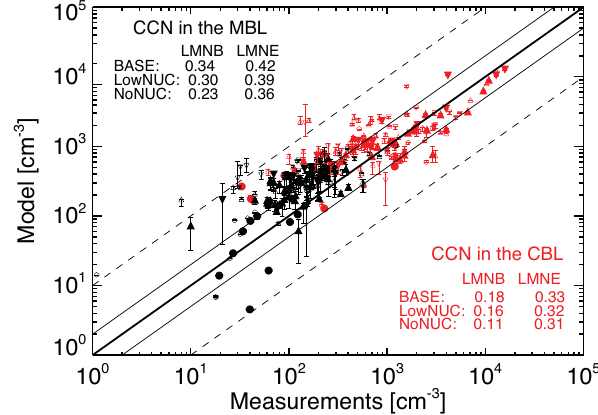
Figure 27. Scatter plot of simulated CCN concentrations in compar- ison with a data set of CCN measurements compiled by Spracklen et al. (2011). Data are classified into two categories: CCN in the MBL (in black) and CCN in the CBL (in red). The upper error bar is for the BASE run, the middle symbol for the LowNUC run, and the lower error bar for the NoNUC run. Large and filled symbols are for measurement duration longer than 10 days, and small and open symbols for less than 10 days. Circle symbols are for super- saturations ( s ) less than 0.2%; upward triangles for s greater than 0.2% and less than 0.8%; and the downward triangle for s greater than